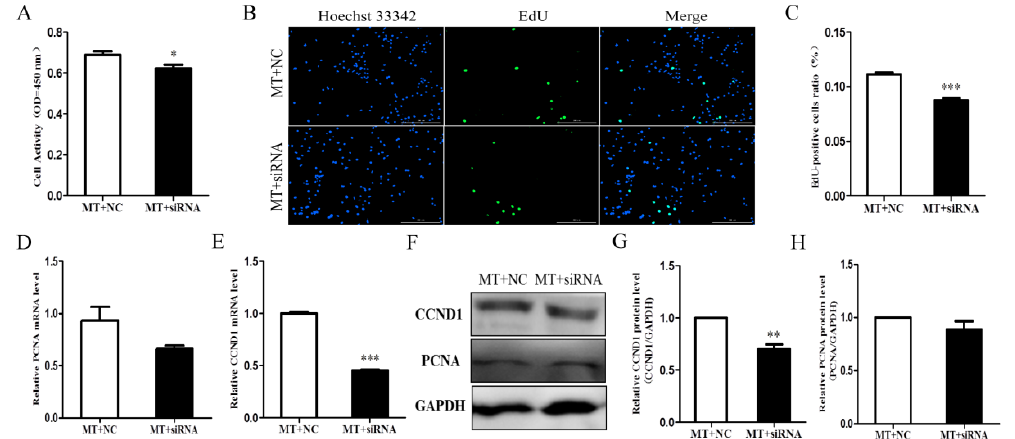
Figure 5. Effects of melatonin on Sertoli cell proliferation after silencing INHA. ( A ) Cell activity of chicken Sertoli cells (n = 3). ( B ) The EdU method was used to measure chicken Sertoli cell proliferation ( × 10 magnification; n = 3). ( C ) Statistical analysis of data in ( B ). The relative mRNA expression levels of ( D ) proliferating cell nuclear antigen (PCNA) and ( E ) Cyclin D1 (CCND1; n = 3 for both). ( F ) The relative protein expression levels of CCND1 and PCNA. Quantitative analyses of the ( G ) CCND1 and ( H ) PCNA protein results (n = 3 for both). *** p < 0.001; ** p < 0.01; * p < 0.05.